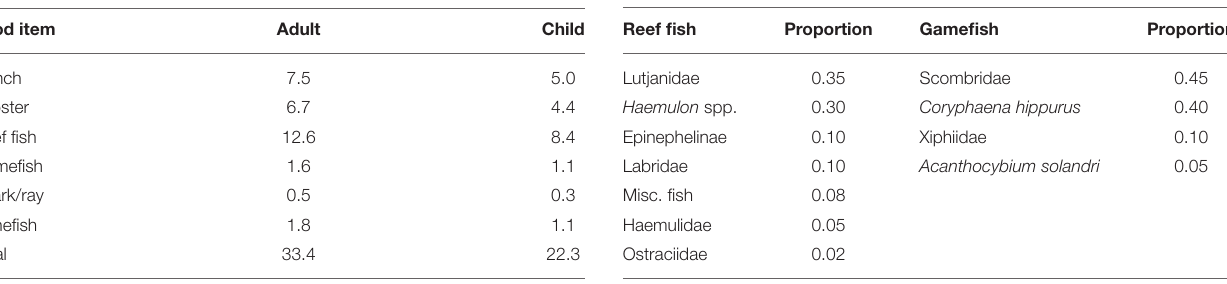
TABLE 2 | Taxonomic allocation used for reef-fish and gamefish for both domestic and tourist consumption in the Turks and Caicos Islands.